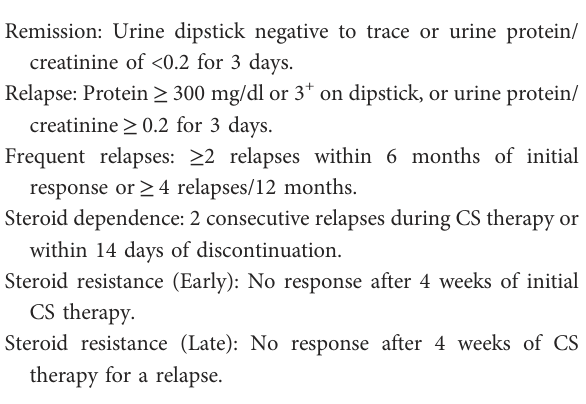
TABLE 1 Corticosteroid therapy for initial episode. Group A (Total duration of therapy 8